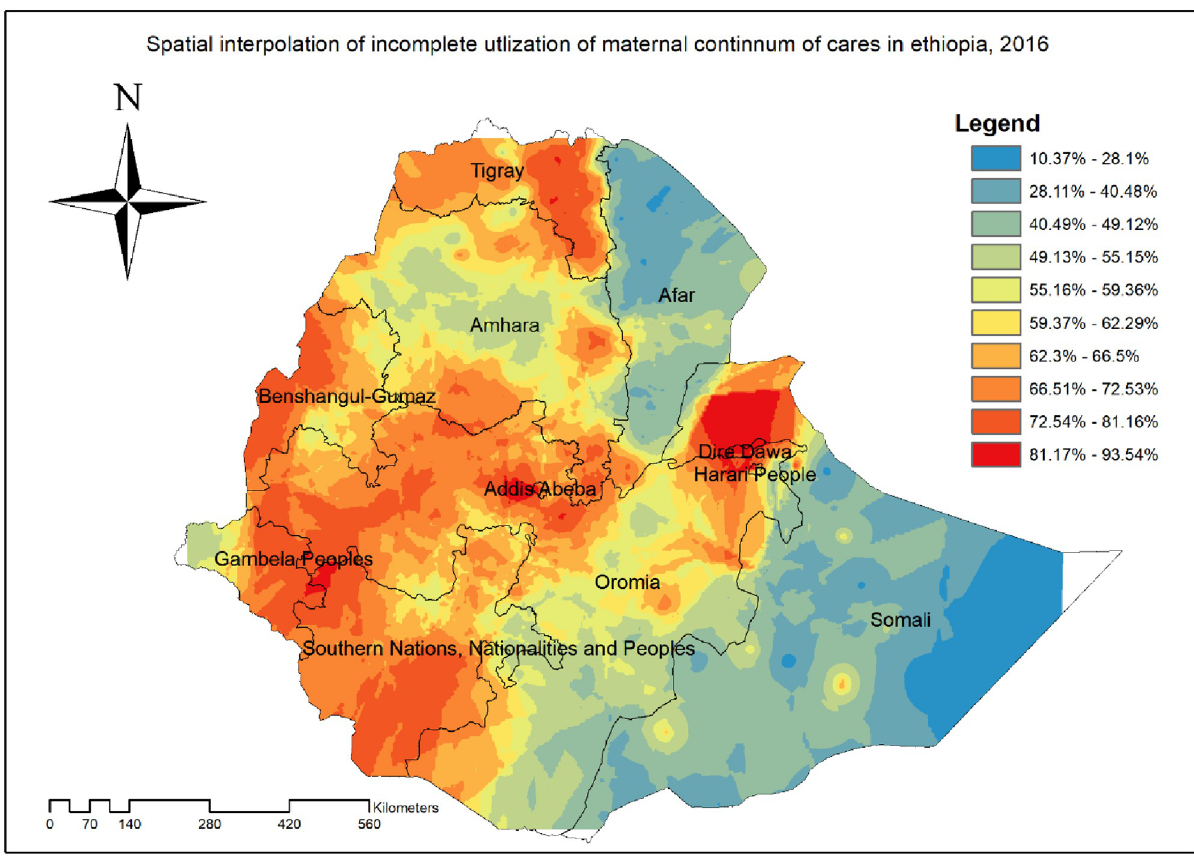
Fig 5. Spatial scan statistical analysis of hotspot areas of incomplete utilization of maternal continuum of care in Ethiopia, produced using Arc GIS version 10.7.